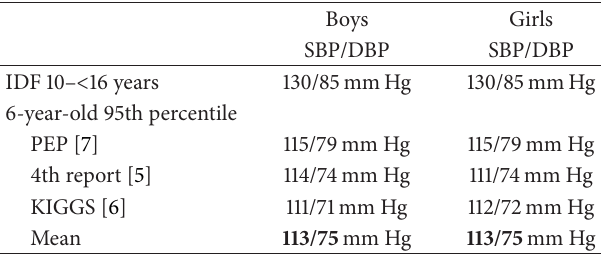
Table2:ComparisonofbloodpressurerecommendationsfromIDF [2] for 10– < 16 year-old children and for 6-year-old children at